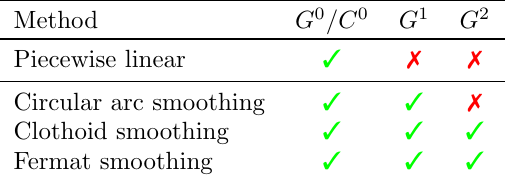
Table 1: Geometric continuity